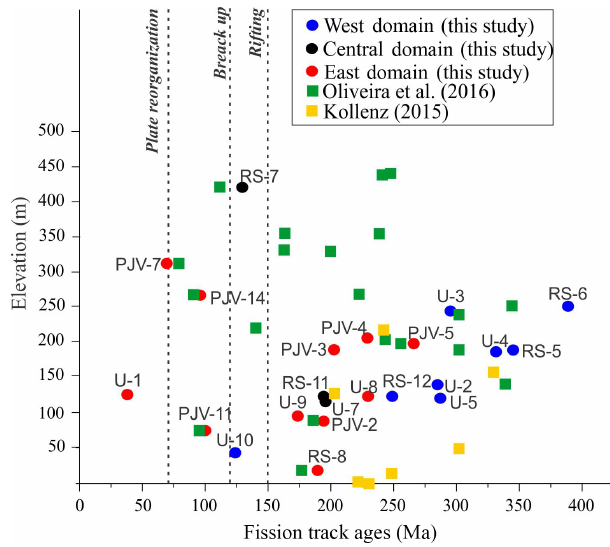
Figure 2. Variation of fission-track ages (Ma) and elevation ( m ) for the samples from Uruguay and Southern Brazil. Data from de Oliveira et al. (2016) and Kollenz (2015) to